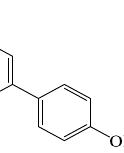
Table 3. Apigenin potential in lowering blood glucose levels.